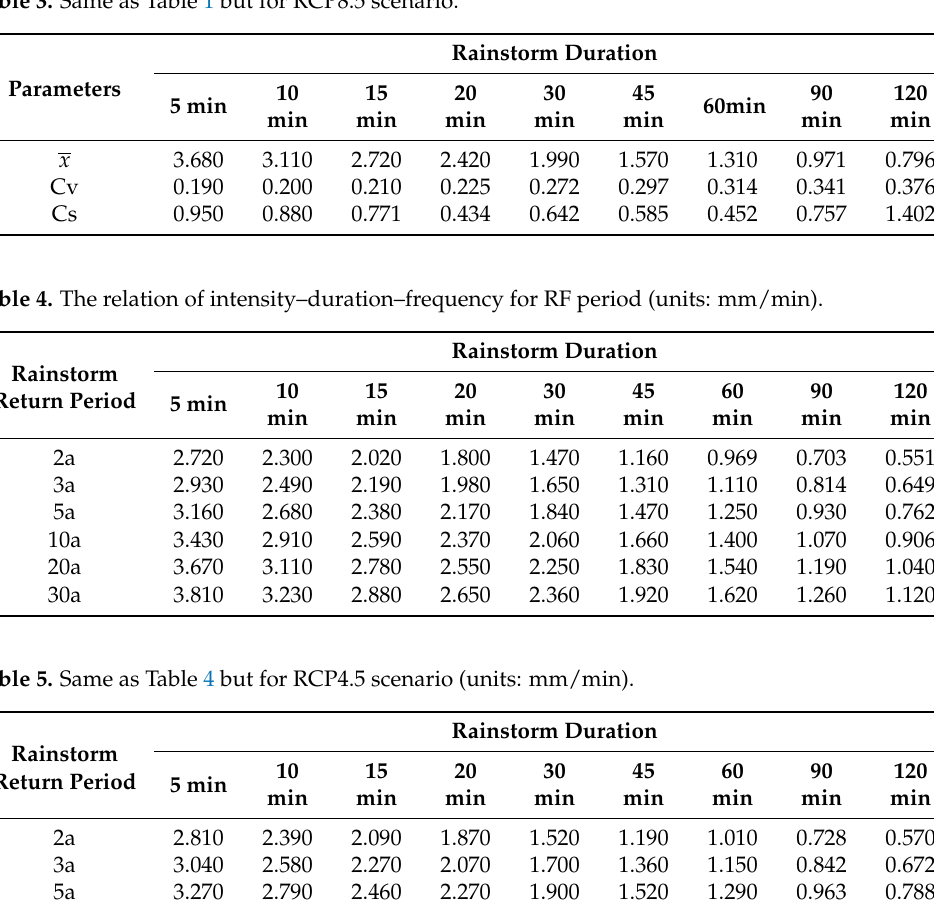
Table 3. Same as Table 1 but for RCP8.5 scenario.